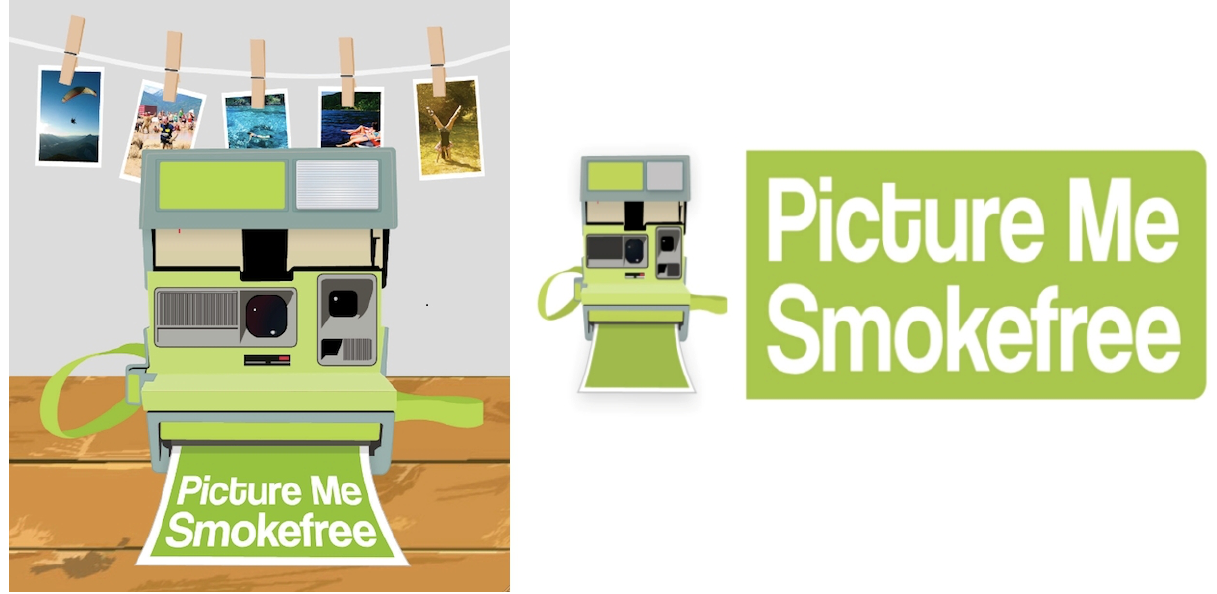
Figure 3. Picture Me Smokefree intervention logo and social media